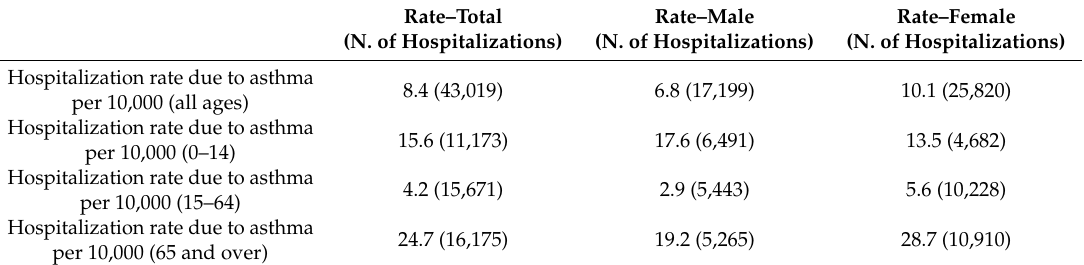
Table 2. Hospitalization rates per 10,000 for asthma by age group and